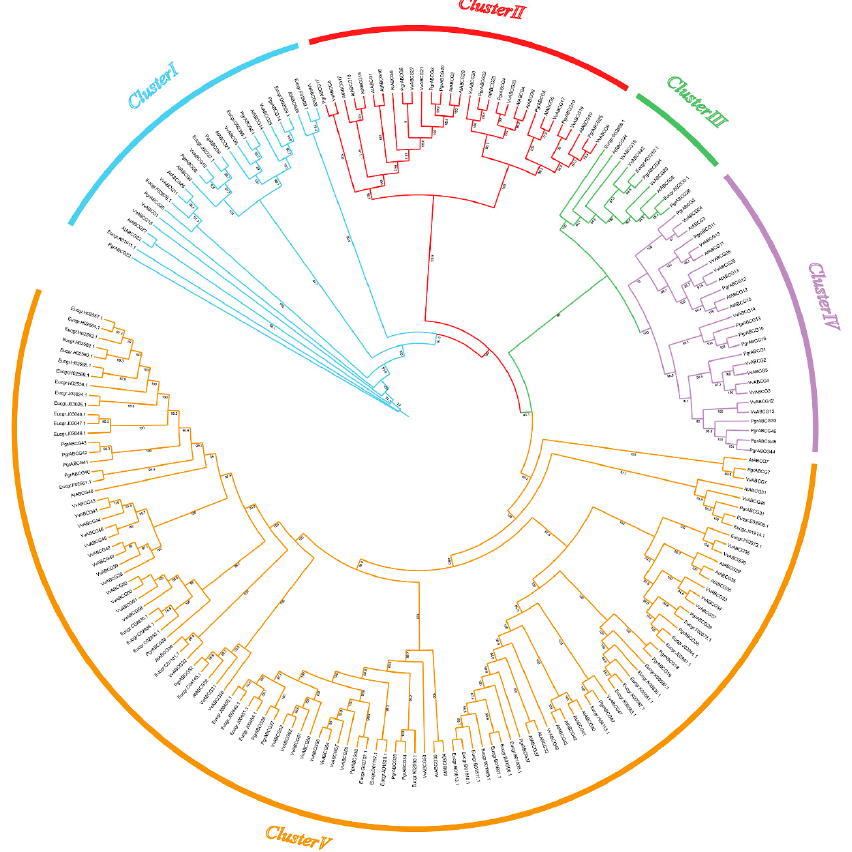
Figure 1. Phylogenetic analysis of ABCG proteins from pomegranate, grape, Arabidopsis , and eucalyptus. The tree was generated with MEGA X using the neighbor-joining method based on 1000 bootstrap replicates.